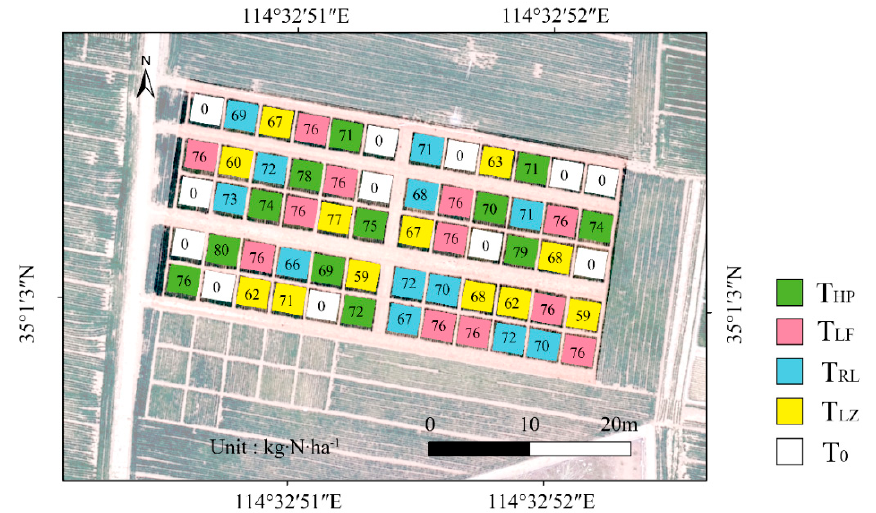
Figure 6. Recommended nitrogen fertilizer amount for topdressing for each unit. (T HP , T LF , T RL , T LZ , and T 0 represent different topdressing methods).